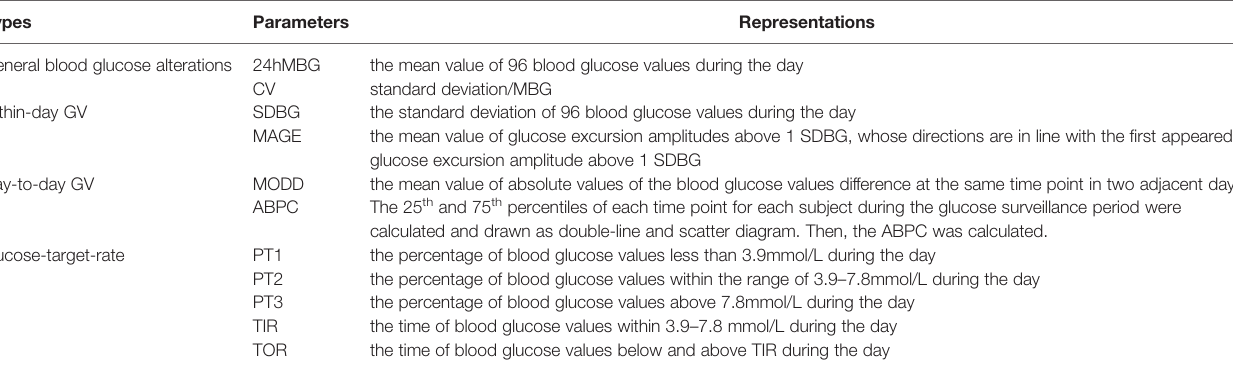
TABLE 1 | Flash glucose monitoring system (FGMS)-related